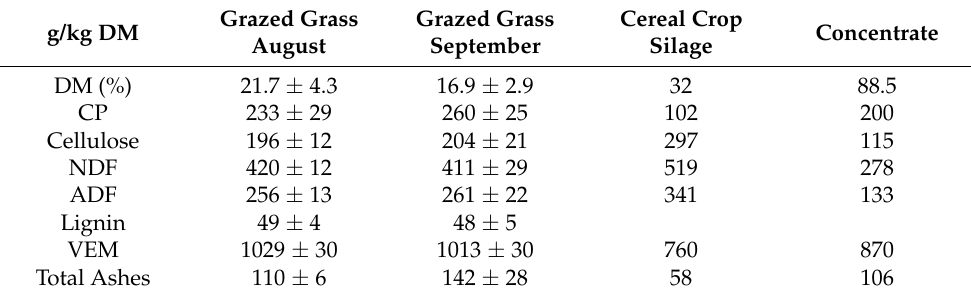
Table 3. Nutritional values of the cereal crop silage, concentrate and grazed grass.